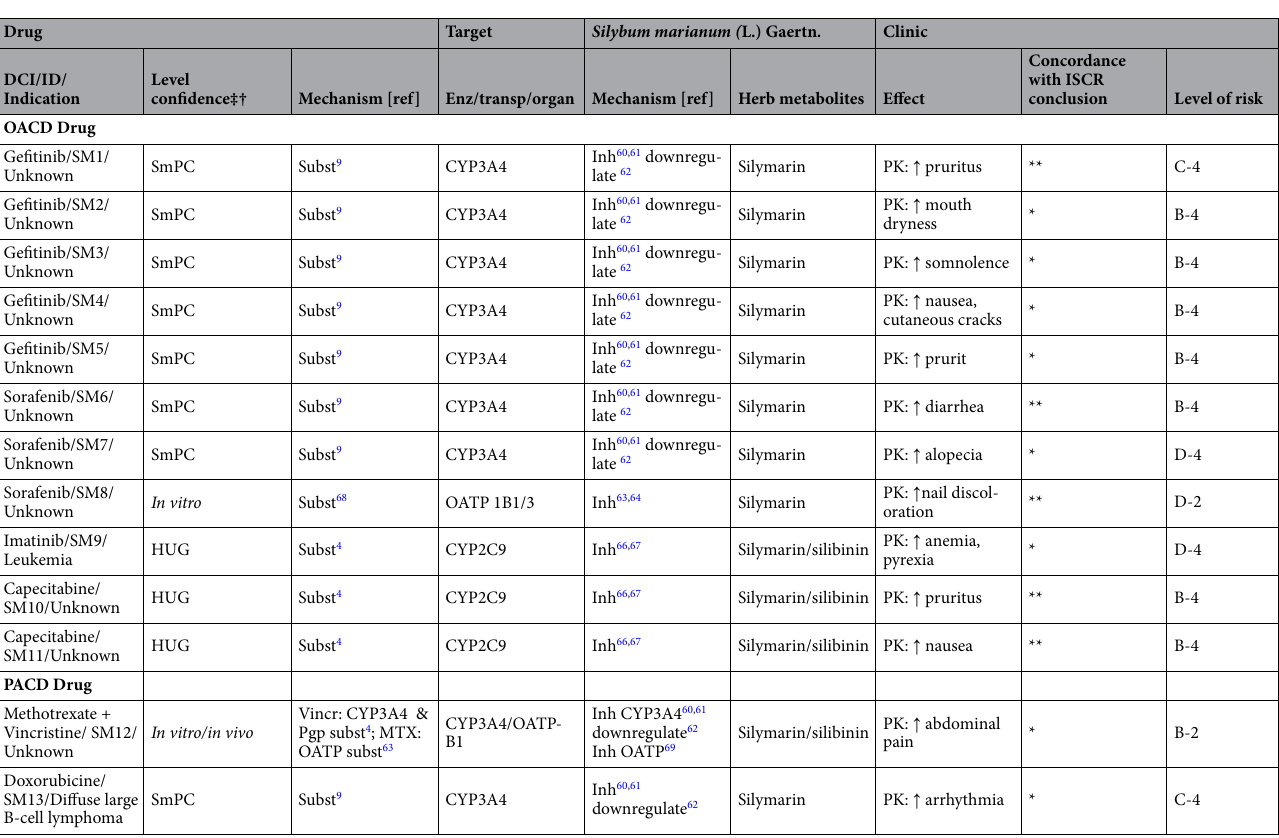
Table 5. Silybum marianum L.- ACD interactions among selected ICSRs. OACD: Oral Anti-Cancer Drug; PACD: Parenteral Anti-Cancer Drug; PD: pharmacodynamic; PK: pharmacokinetic; Pgp: P-glycoprotein; CYP3A4: Cytochrome P 450 isoform3A4; OATP: Organic Anion Transporting Protein; Vinc: Vincristin; MTX: Methotrexate; Subst: Substrate; Inh: Inhibitor; Ind: Inducer; n.k.: not known; Enz: enzyme; Transp: Transporter; ‡SmPC: Summary of product Characteristics; †HUG: University Hospital of Geneva 4 . "Scoring" for the significance of the indicators "*",